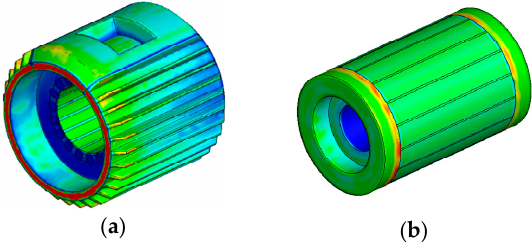
Figure 16. Heat transfer coefficient distribution of the motor: ( a ) Heat transfer surfaces distribution of the stator and frame; ( b ) Heat transfer coefficient distribution of the rotor.